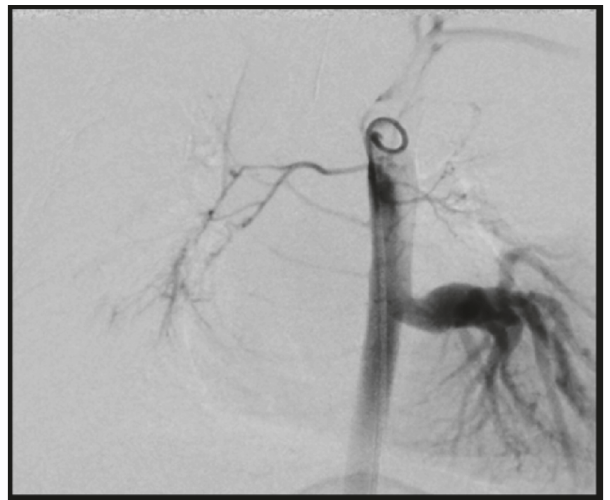
Figure 2: Digital subtraction cineangiography. Contrast injected into the left pulmonary artery shows a small left pulmonary artery perfusing only the left upper lobe of the lung. No flow is seen in the left lower lobe. There is no left lower pulmonary